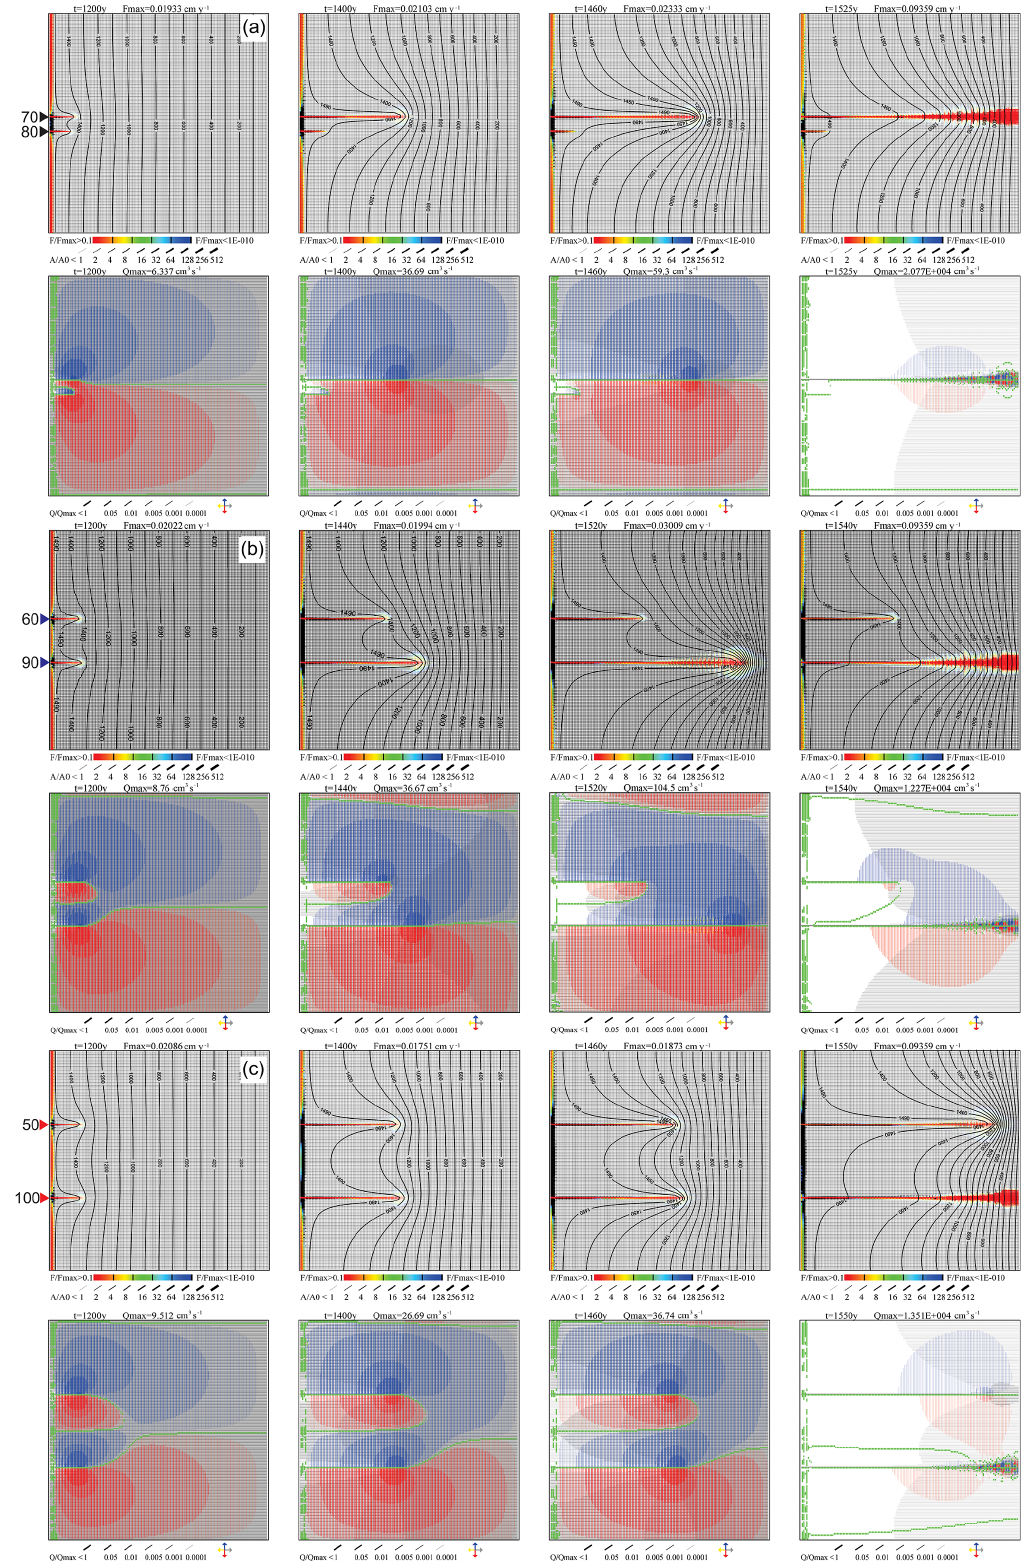
Figure 12. Interaction of two wormholes seeded at distances of 10 (a) , 30 (b) , and 50 (c) nodes. First rows of panels for each case show aperture widths and relative dissolution rates; second rows show flow rates and directions. All codes and conditions as described in Fig.